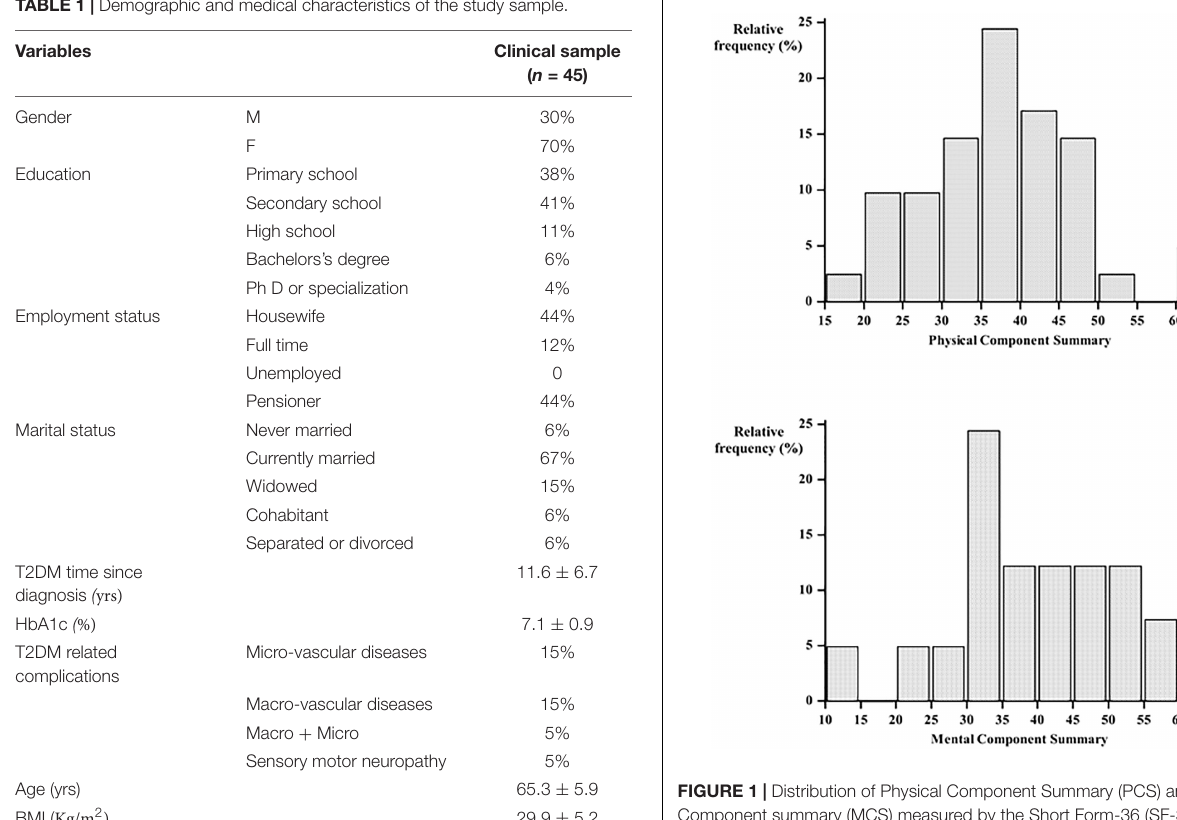
TABLE 1 | Demographic and medical characteristics of the study sample. Variables Clinical sample